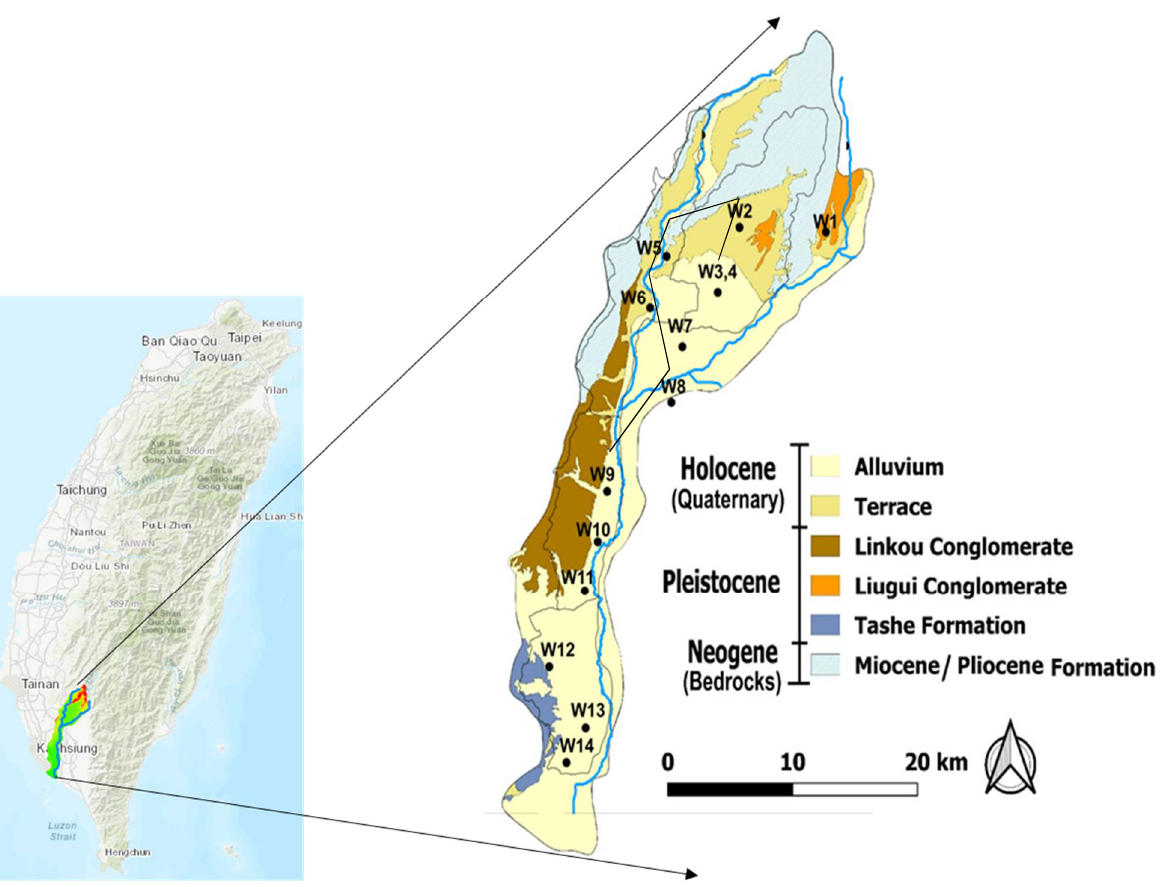
Figure 1. Description of study area with outcrop formation, locations of observation wells and Kaoping River indicated by blue line in the map [25]. Table 1. Observation wells depth and aquifers position in study area.